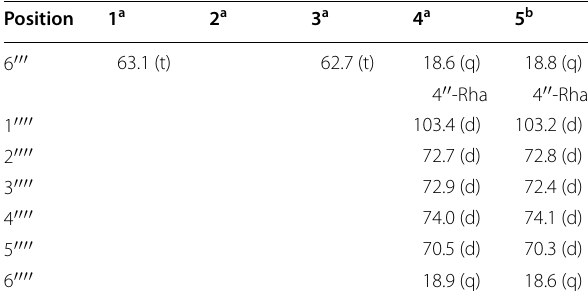
Table 2 13 C NMR spectroscopic data of compounds 1 – 5 ( δ